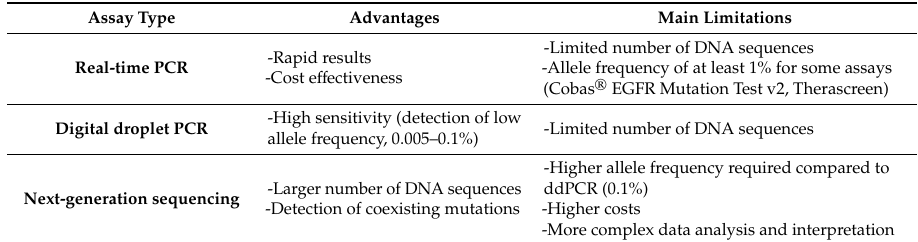
Table 1. Liquid biopsy assays with main advantages and limitations. Abbreviations: ddPCR: digital droplet